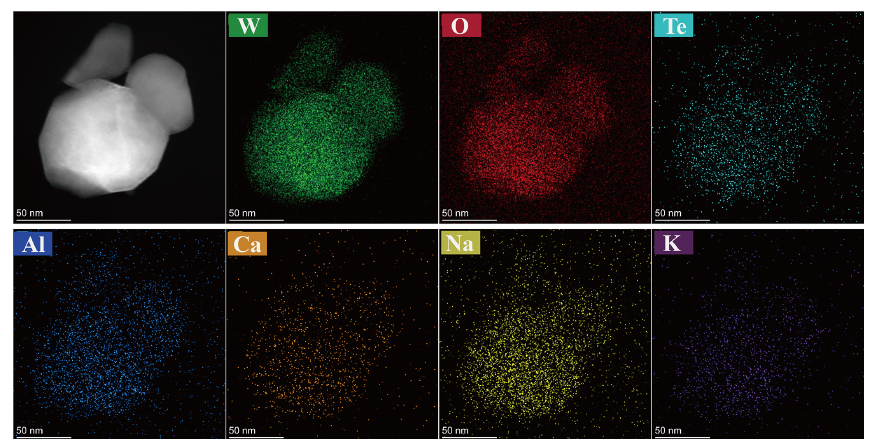
Figure 8. Energy-dispersive spectroscopy (EDS) element maps of the major elements, including W and O, as well as the minor elements Te, Na, K, Ca, and Al.